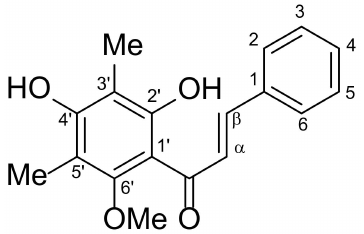
Figure 1. Structure of